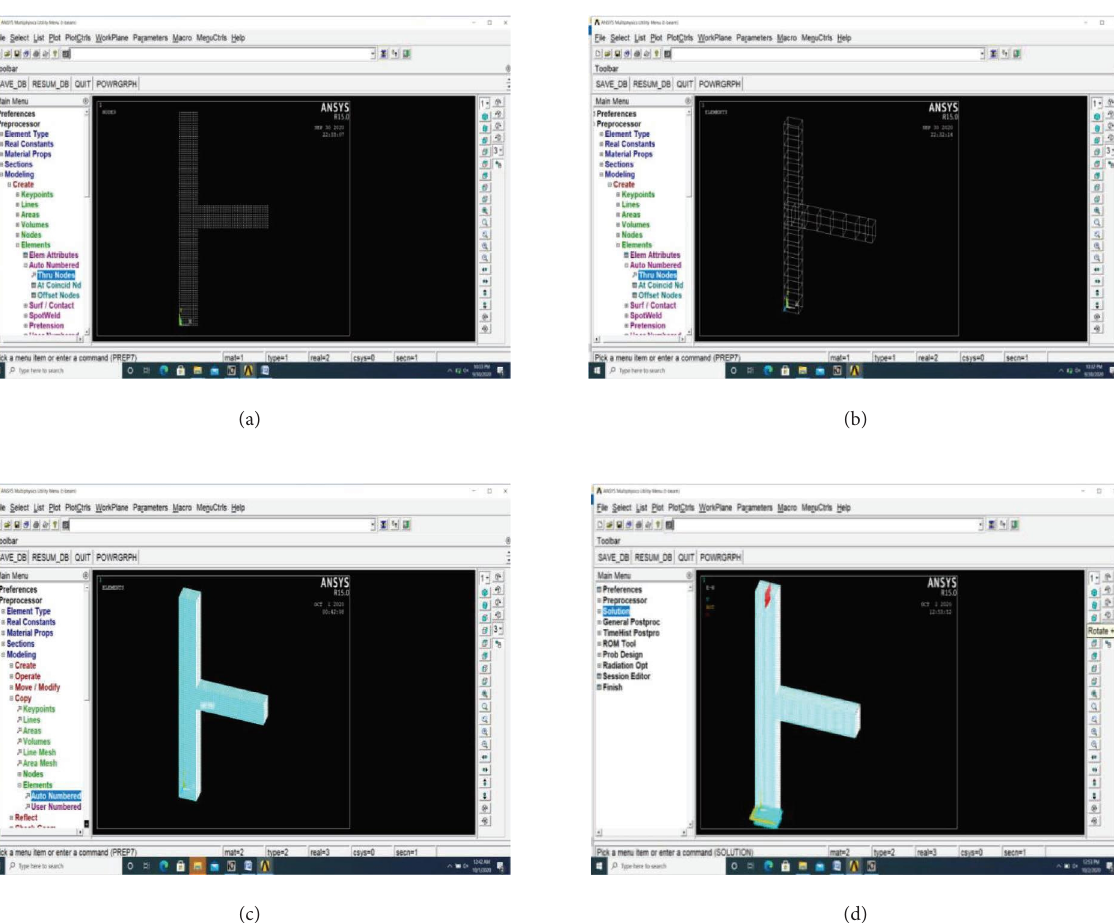
Figure 25: ANSYS fnite element modelling: (a) node formation, (b) generation of steel element, (c) generation of solid element, and (d) loading condition.